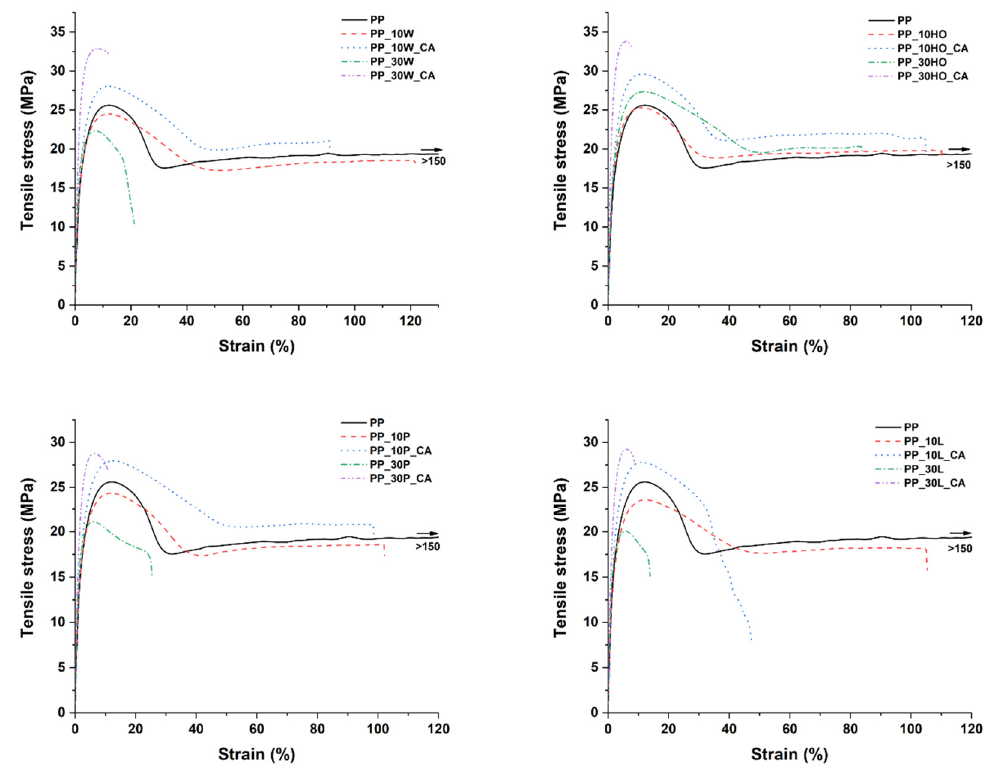
Figure 8. Typical stress–strain curves from tensile tests of PP-based composites.